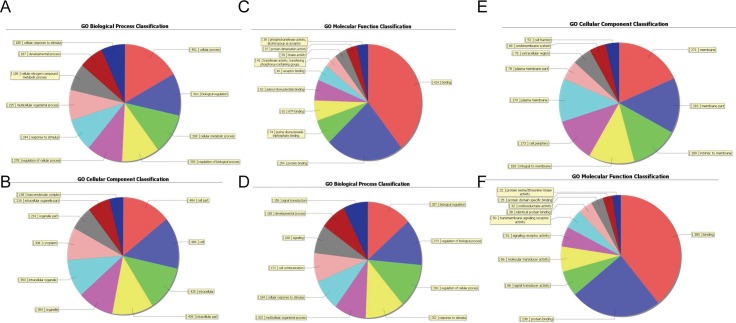
Pie charts showing the significant enrichment terms.The pie chart shows the top ten counts of the significant enrichment terms. The ontology covers three domains: Biological Process, Cellular Component and Molecular Function. Fisher’s exact test is used to find if there is more overlap between the DE list and the GO annotation list than would be expected by chance. The p-value denotes the significance of GO terms enrichment in the DE genes. The lower the p-value, the more significant the GO Term (p-value< = 0.05 is recommended) (A-C) The highest enriched GOs targeted by up-regulated transcripts: A, Biological process (BP), B, Cellular component (CC), C, Molecular function (MF). (D-F) The highest enriched GOs targeted by down-regulated transcripts: A, Biological process (BP), B, Cellular component (CC), C, Molecular function (MF).